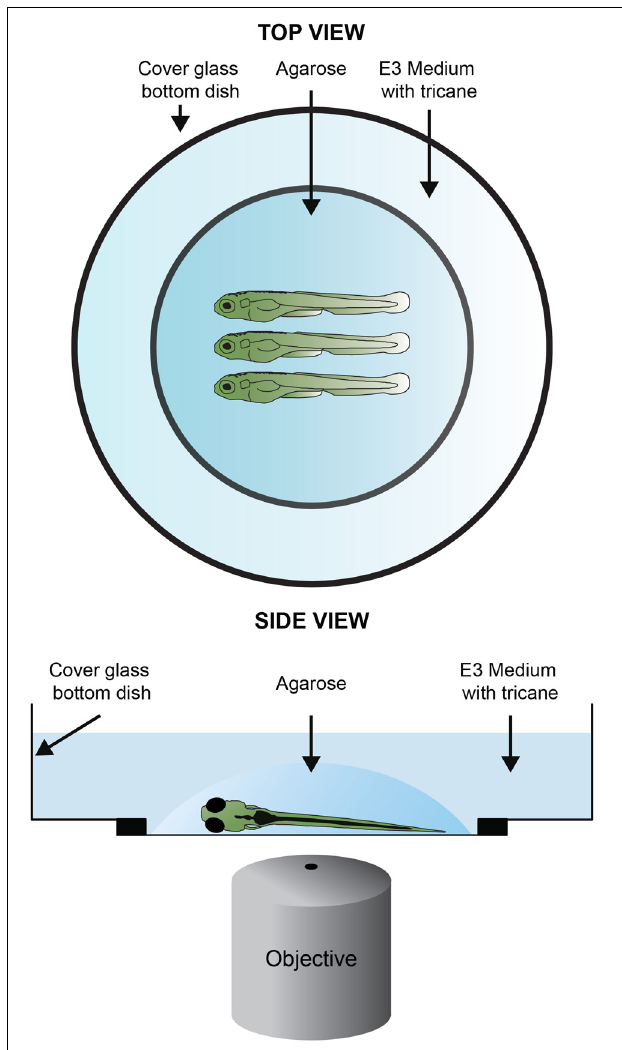
FIGURE 3 | Sample mounting for confocal imagin. One to four larvae are, laterally and equally oriented, placed in the center of a cover glass bottom dish. One drop or two of 1% LMP (low–melting point) agarose in E3 are added covering the larvae. If needed readjust the position of the larvae using an embryo loop. Once the agarose solidifies, the embryos are covered with methylene-blue-free E3 medium containing tricaine and the lid is placed on top of the